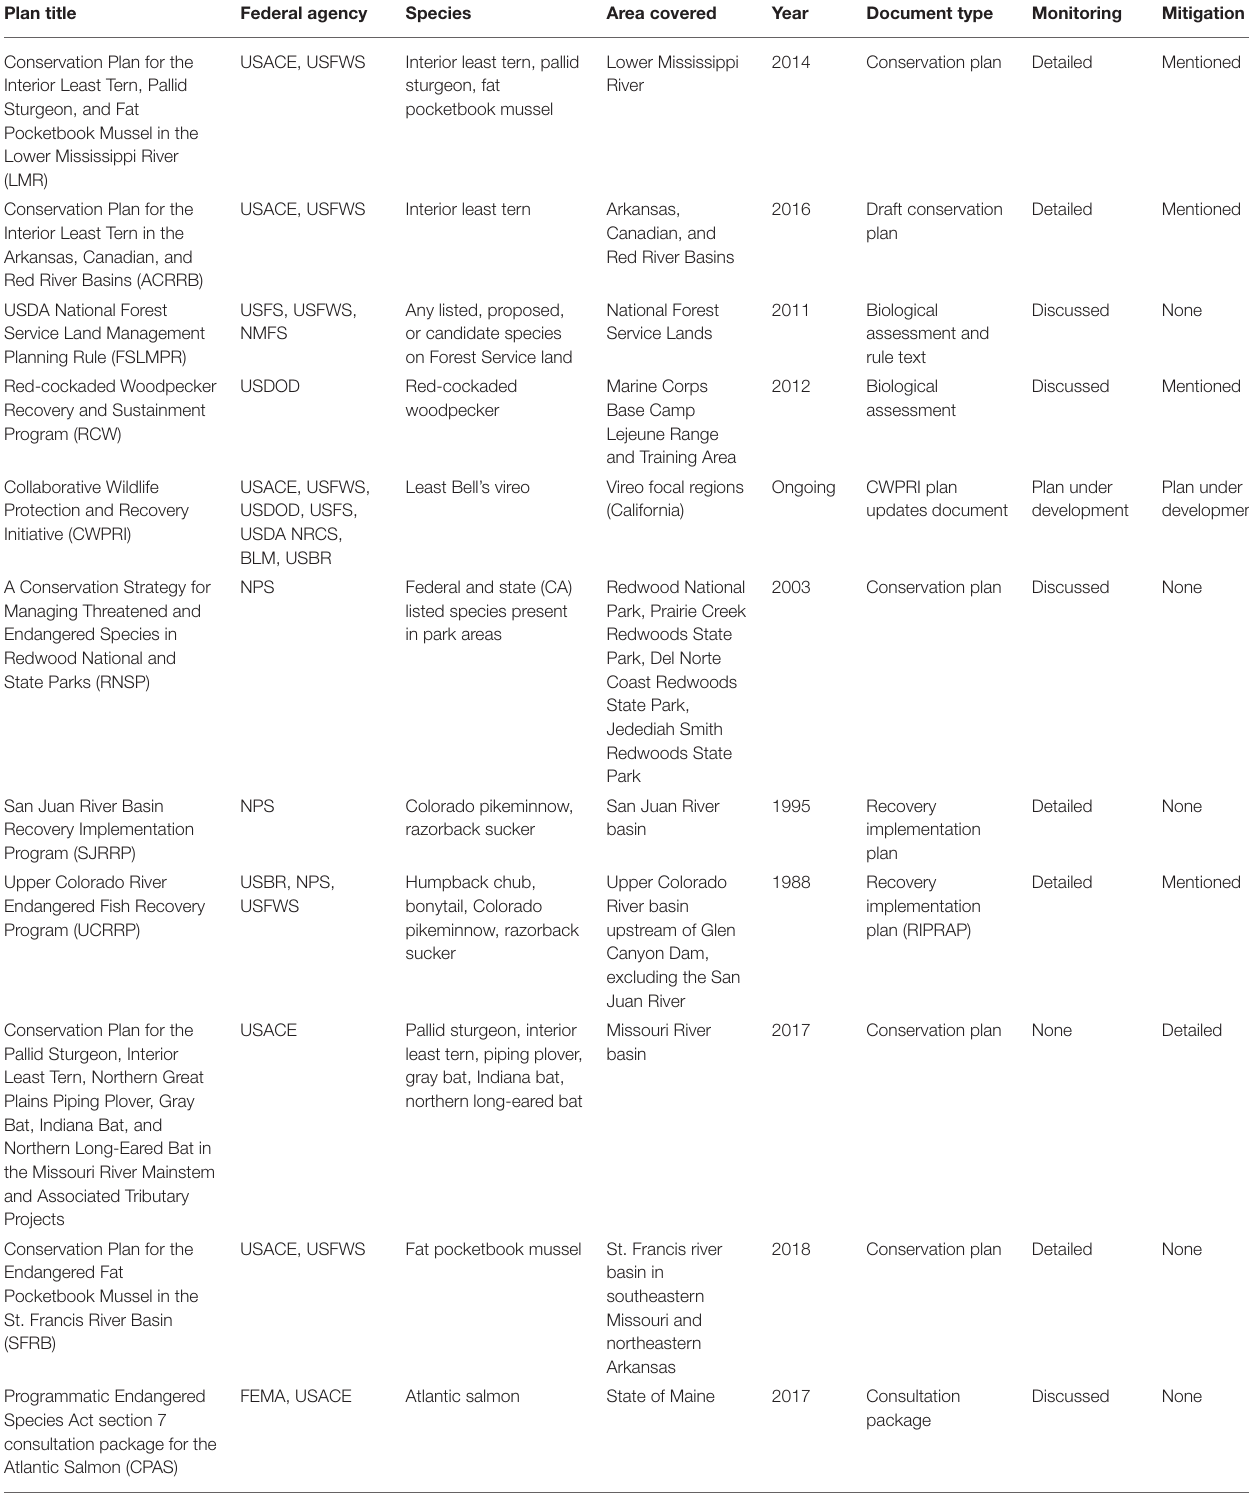
TABLE 1 | 7(a)(1) plans included in the